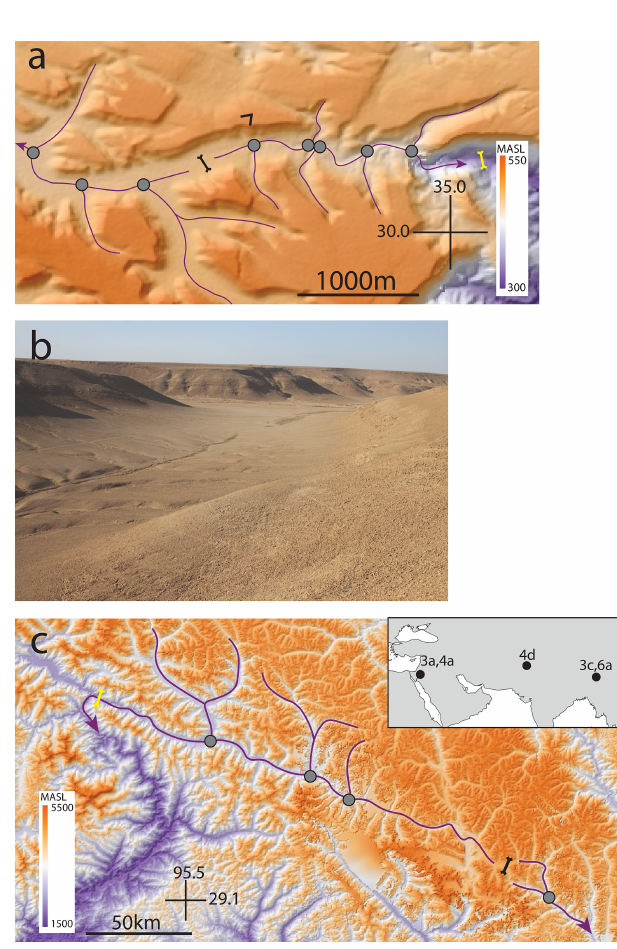
Figure 3. Examples of valleys with wind gaps and major conflu- ences with side tributaries (gray circles). Major channels are marked in purple, and their flow direction is marked with an arrow. (a) A map based on a TanDEM-X DEM (Krieger et al., 2007) showing an example from Wadi Grofit in the Negev highlands along the Arava escarpment, Israel. The current location of the wind gap is marked by a bold forked black line. The approximated initial location of the wind gap is marked with a forked yellow line (Harel et al., 2019). A black v-shaped symbol open to the southwest shows the locations from which the picture in panel (b) was taken. (b) A picture of the wind gap shown in panel (a) . Note the low relief of the wind gap and a side tributary that joins the valley from the left-hand side of the picture. (c) A map based on a GMTED2010 DEM (Danielson and Gesch, 2011) showing the wind gap and confluences along the Parlung valley, China. Wind-gap symbols are as in panel (a) . In both the Grofit and Parlung examples, the wind gap likely traversed con- fluences with side tributaries (gray circles), resulting in their barbed morphology. The inset map shows the general location of the field examples presented in this and other figures; figure numbers are specified next to each